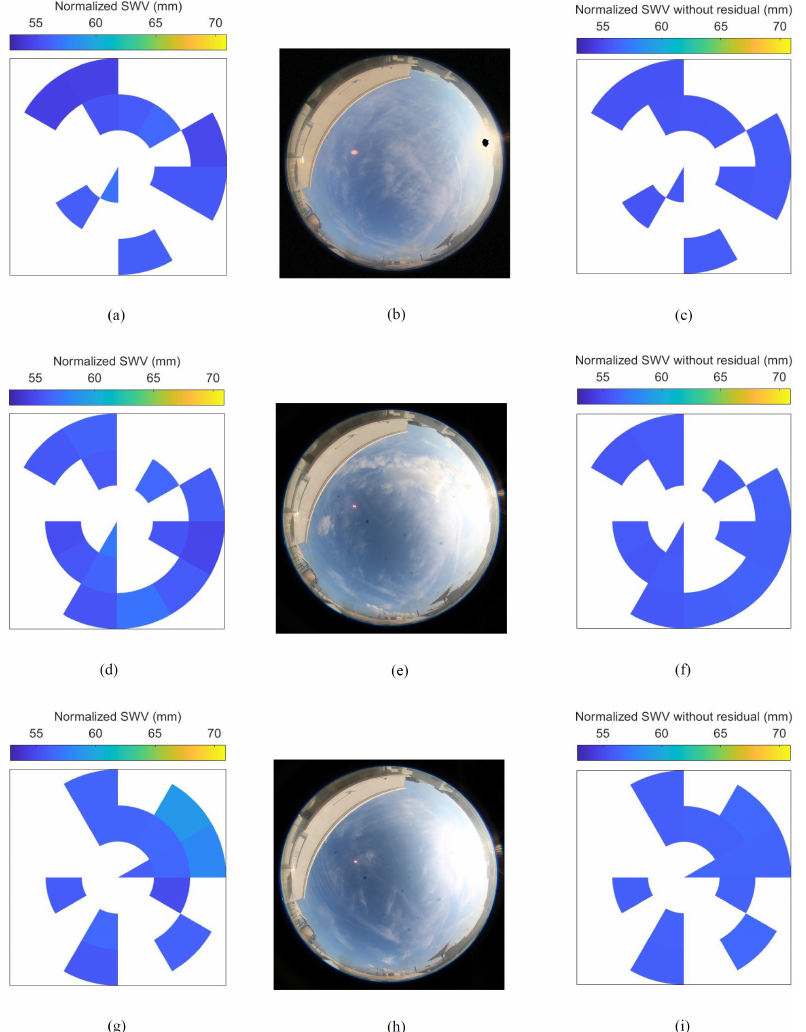
Figure 9. Left: Spatial plots of normalized SWV on 20 April 2016 at ( a ) 08:00, ( d ) 08:20, and ( g ) 08:40 local time. Center: Sky images on the same day at ( b ) 08:00, ( e ) 08:20, and ( h ) 08:40 local time. Right: Spatial plots of normalized SWV without added residual on the same day at ( c ) 08:00, ( f ) 08:20, and ( i ) 08:40 local